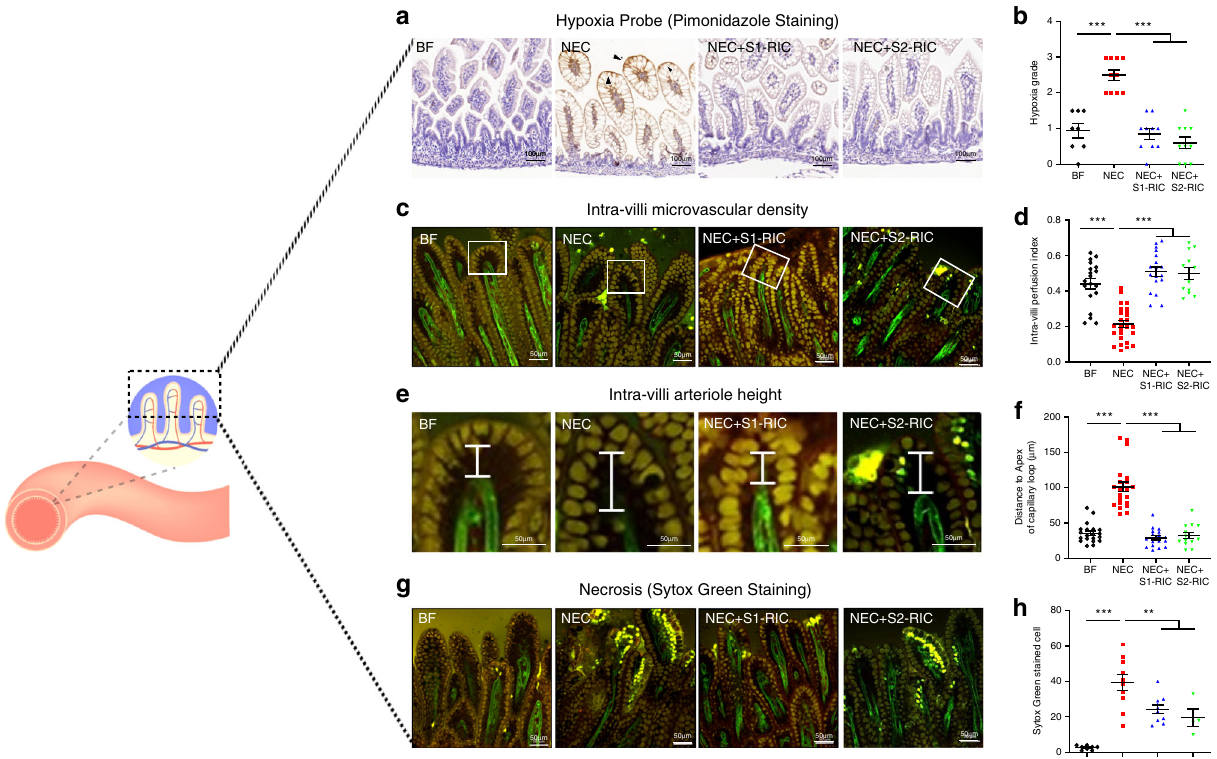
Fig. 5 RIC improves intestinal villi microvasculature and reduces ischemia and necrosis of enterocytes at the villi tip. a , b Pups were injected with pimonidazole, a sensitive marker which allows localization of intestinal ischemia. Data represent immunohistochemistry of pimonidazole in the ileum comparing breastfed (BF) control ( n = 8), NEC ( n = 10), NEC with Stage 1 RIC ( n = 10), and NEC with Stage 2 RIC ( n = 10). Scale bars are equivalent to 100 µ m in the images shown. c Intra-villi microvasculature was investigated in Rosa mT/mG/ + ; Tie2-Cre using TPLSM and compared between BF, NEC, NEC with Stage 1 RIC, and NEC with Stage 2 RIC ( n = 4 per group; and minimum of 2 measurements were obtained per group). d Villus perfusion index was calculated as the ratio of the area of intra-villi arterioles to the area of the whole villi and compared between the listed groups. e , f The distance between the apex of the capillary loop and the apical side of the villi epithelium was measured and compared between listed groups. g Cell death (yellow staining in the tip of villi) in the ileal epithelium was detected using Sytox Green, a marker of necrosis which does not permeate into live cells but binds to cellular nucleic acids in dead cells, staining them with intense green fl uorescence and was compared between listed groups. h Necrotic cells were counted in the listed groups (* p < 0.05; ** p < 0.01; **** p < 0.0001). Data were compared using two-sided one-way ANOVA with post hoc Turkey test (** p < 0.01; **** p < 0.0001). Scale bars in ( c , e and g are equivalent to 50 µ m, and data are presented as mean ± SEM. Source data are provided as a Source Data fi